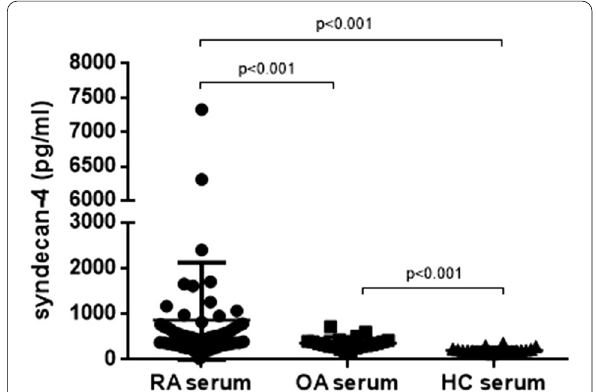
Fig. 1 The comparison of syndencan-4 concentrations among serum from 60 RA patients, 20 OA patients and 20 healthy controls. RA: rheumatoid arthritis; OA: osteoarthritis; HC: healthy